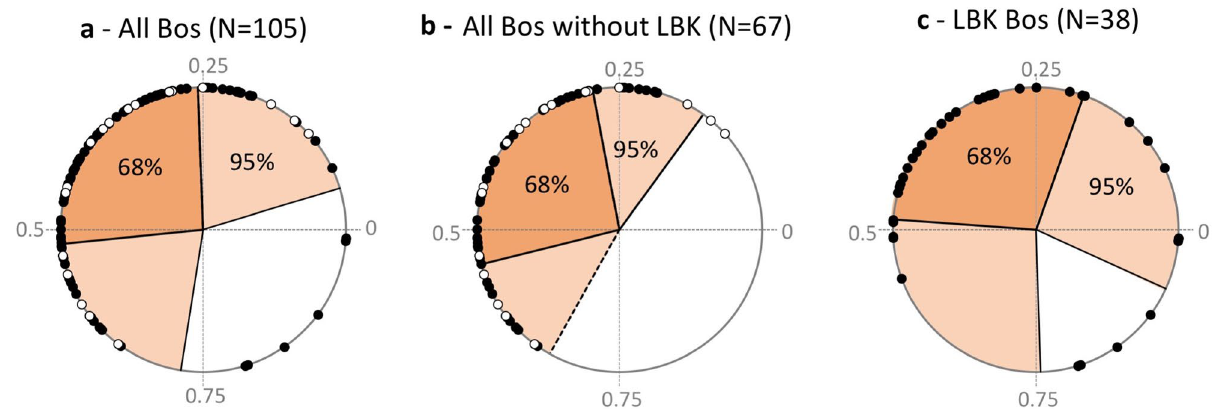
Figure 3. Distribution of cattle births throughout the annual cycle, from the sequence of δ 18 O values measured in the third molar (M3). ( a ) All European sites; ( b ) European sites without Linearbandkeramik sites; ( c ) Linearbandkeramik sites only. The a- and b- datasets include lower (•) and upper third molars (o). Data from the upper M3 were corrected for the purposes of comparison with the lower M3. Only lower molars are included in the statistics. The dark shaded area represents the main birth period (when 68% of births occur); births outside the 95% interval are out-of-season